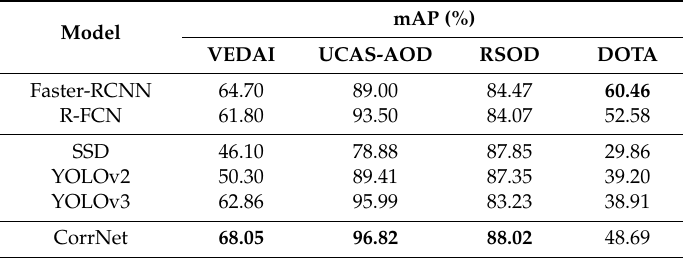
Table 6. Comparative detection performance of the CorrNet and other detection network (The best results are marked in